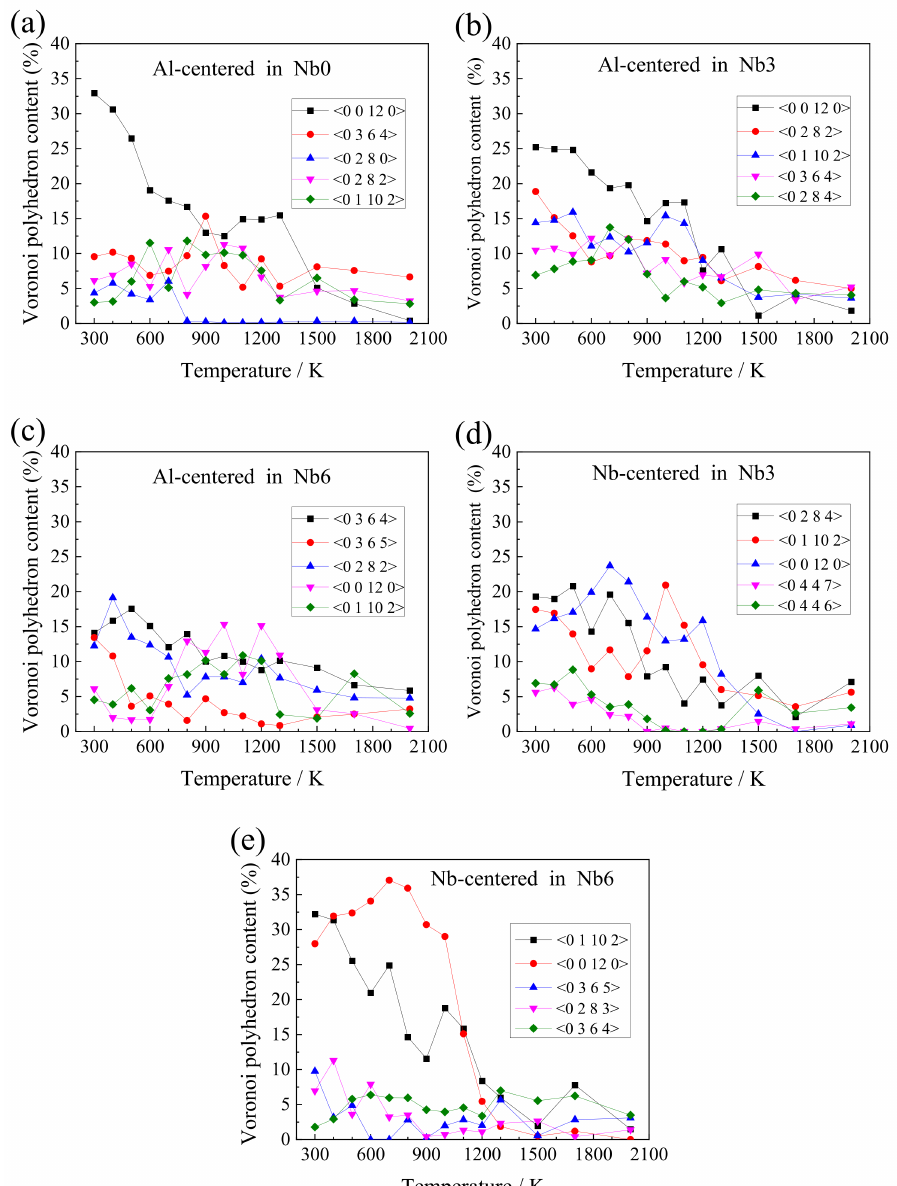
Figure 8. Changes of Voronoi polyhedron content in simulated amorphous alloys during cool- ing from 2000 K to 300K: (a) Al-centered in Nb0; ( b ) Al-centered in Nb3; ( c ) Al-centered in Nb6; ( d ) Nb-centered in Nb6 and ( e ) Nb-centered in